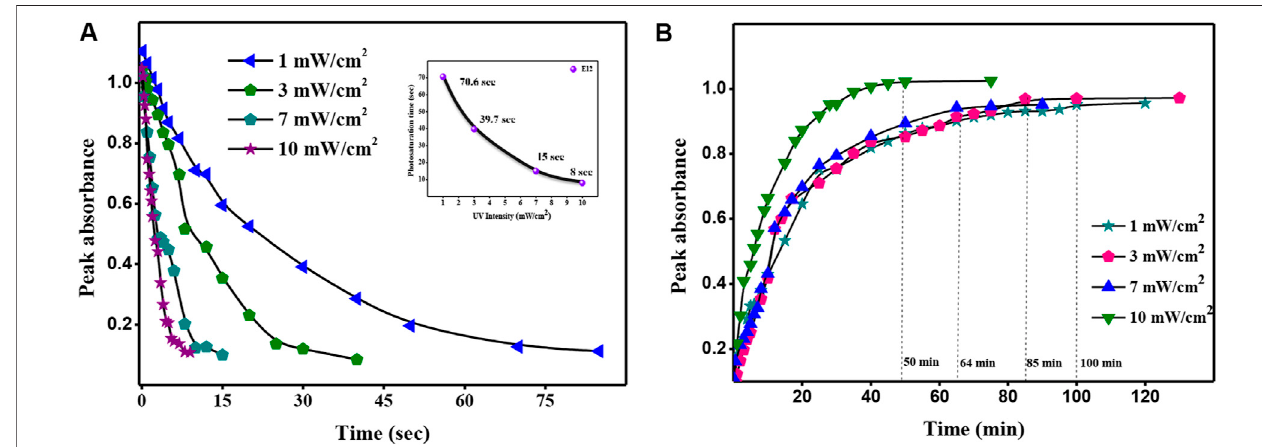
FIGURE 5 | (A) Photosaturation time versus UV intensity plot for E – Z isomerization and (B) Thermal back relaxation or Z – E isomerization of compound E12 with different intensities.